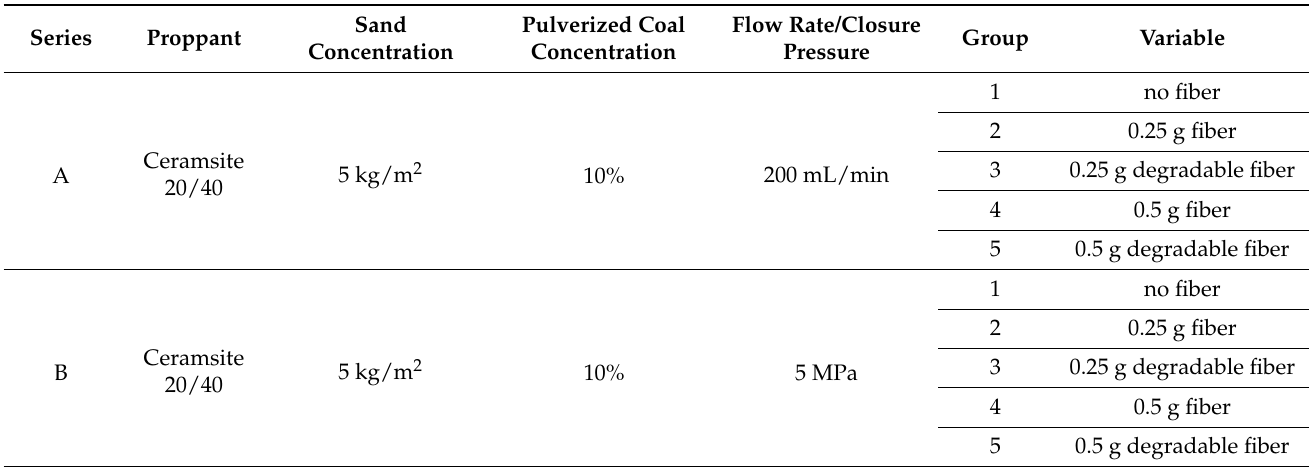
Table 1. Experimental program.